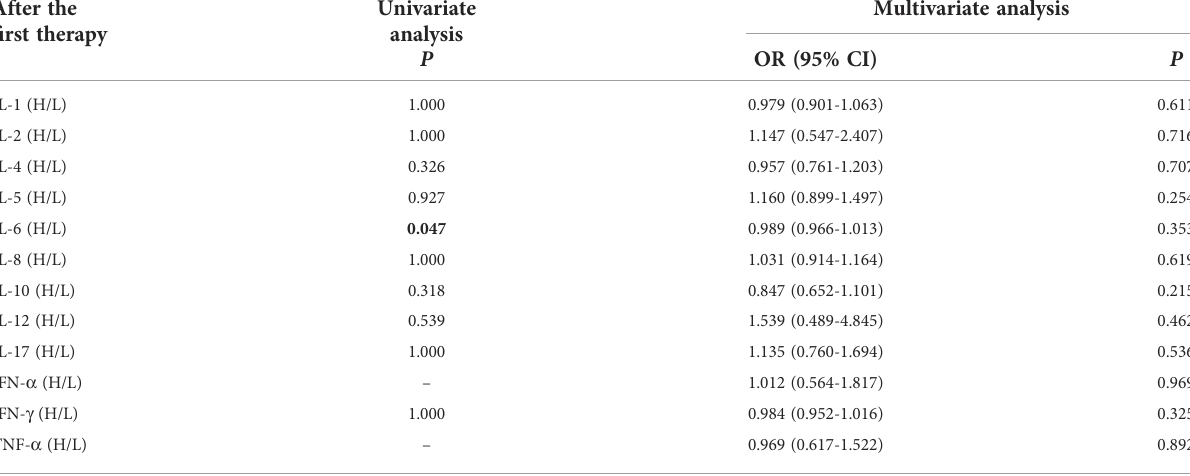
TABLE 8 Univariate and multivariate analysis results of cytokine levels after the fi rst cycle therapy between CB and NCB. After the fi rst therapy